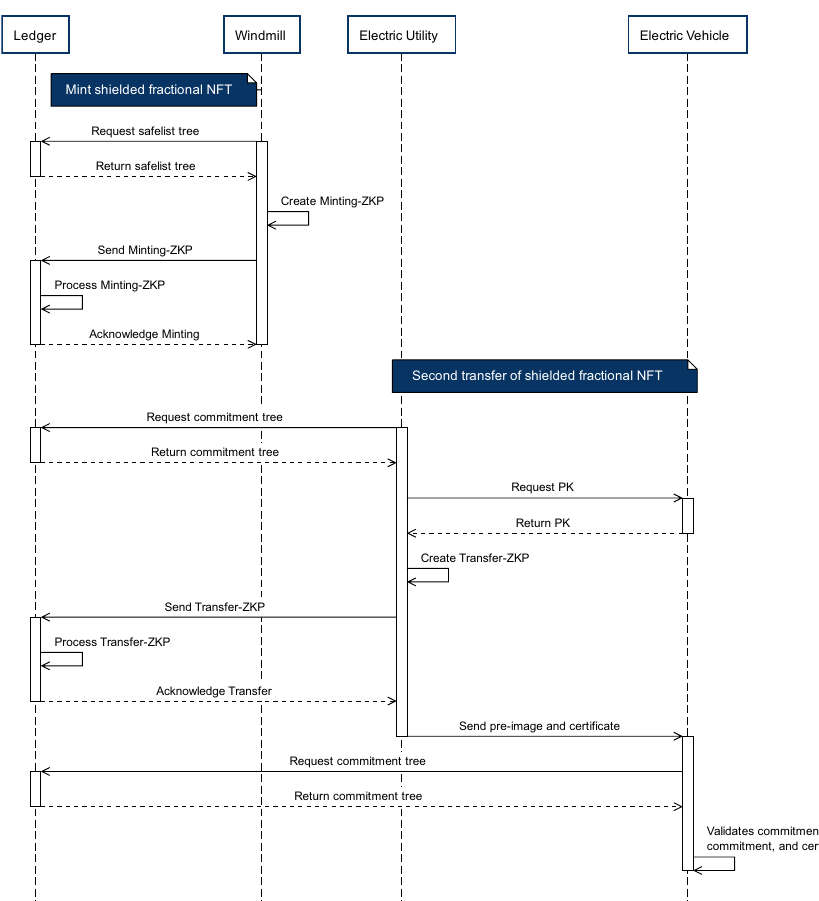
Fig. 3 Process of minting and transfer of proof‑of‑origin